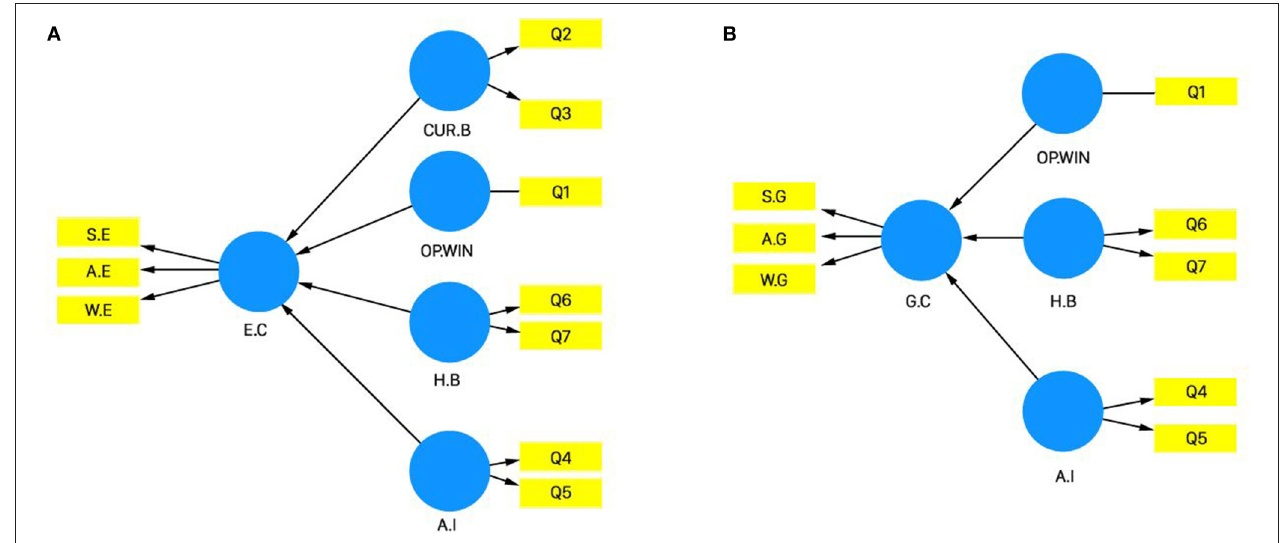
FIGURE 6 | Structural model; left to right: (A) EC. (B) GC.